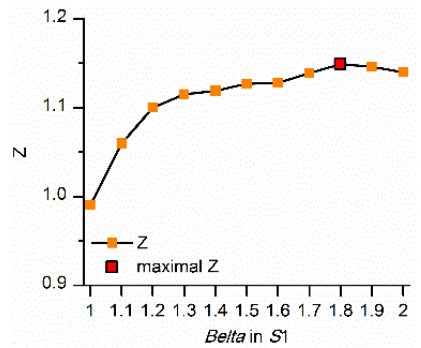
Figure 12. Values of parameter evaluation function Z in 𝑆1 with various 𝛽 .